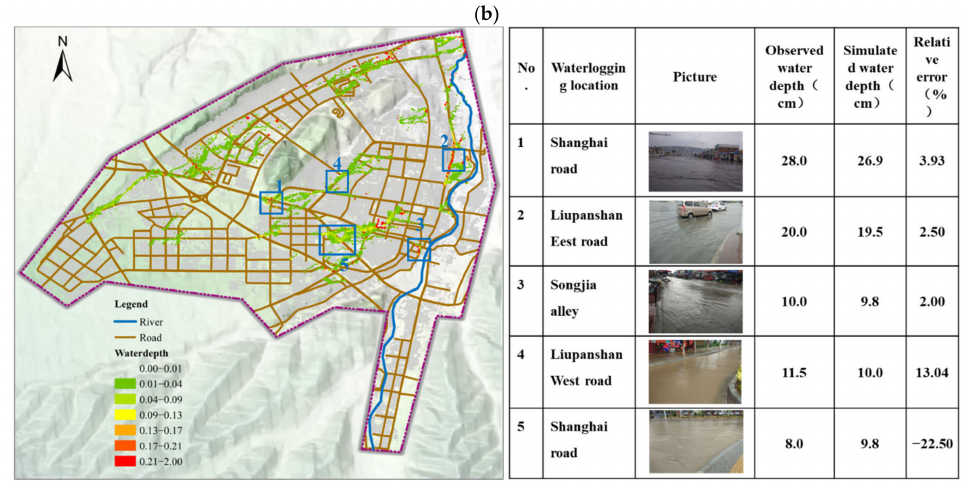
Figure 8. Comparison of simulated and observed water depths; ( a ) 20170727 rainstorm; ( b ) 20180821 rainstorm.